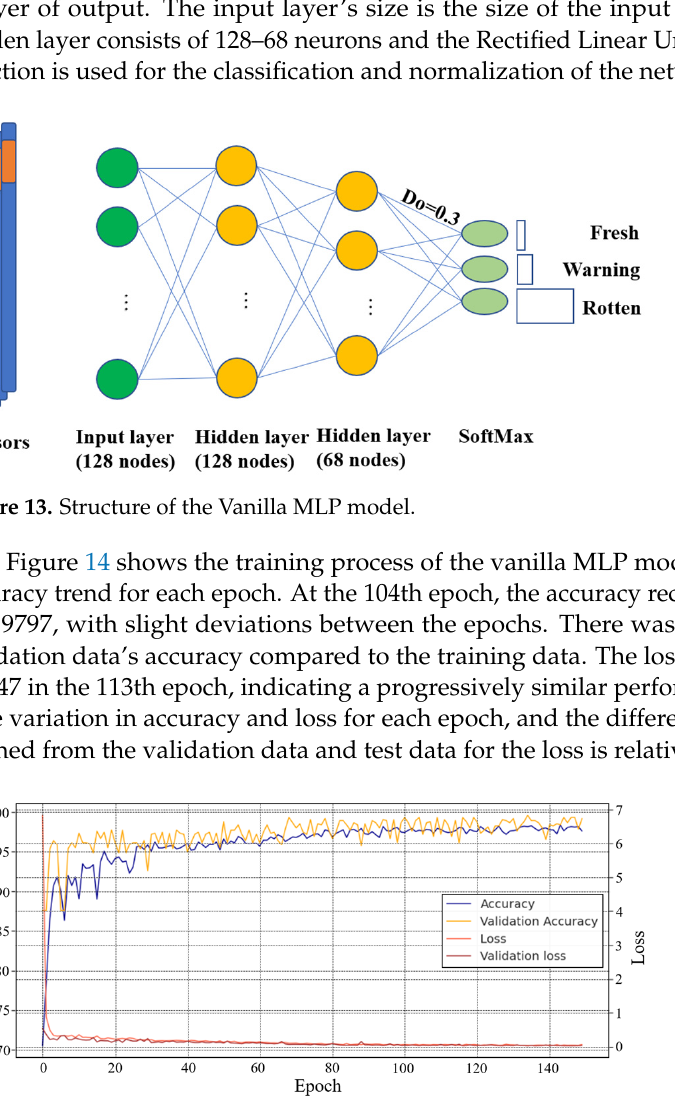
Figure 14. Training process of the Vanilla MLP model.